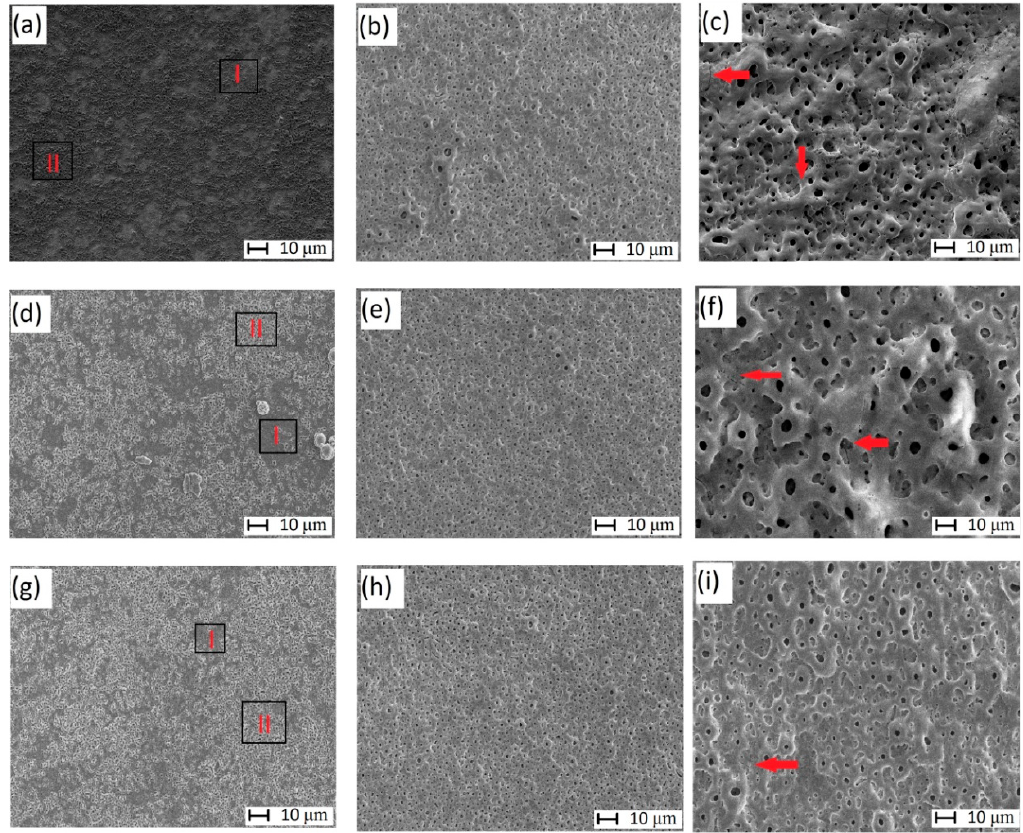
Figure 2. SEM microstructure images of the MAO coatings with various MAO process parameters: